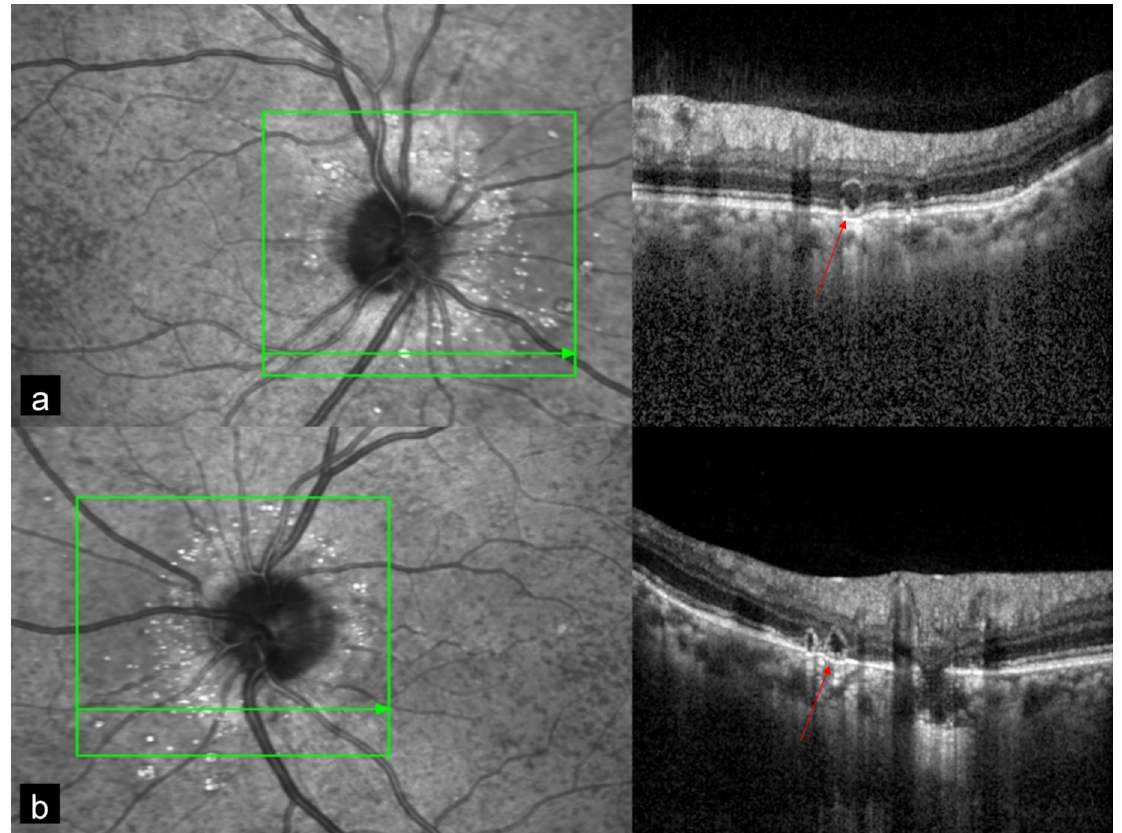
Figure 5: SD-OCT of the right eye (a) and the left eye (b) showed comet lesions as irregular hyporeflective spaces with hyperreflective inner border and focal debris like deposits above the retinal pigment epithelium (red